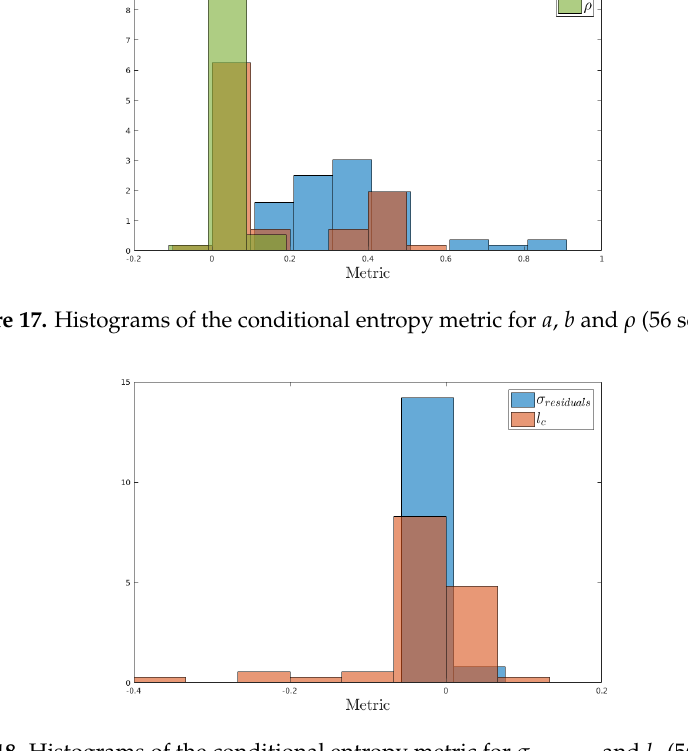
Figure 18. Histograms of the conditional entropy metric for σ residuals and l c (56 scenarii).